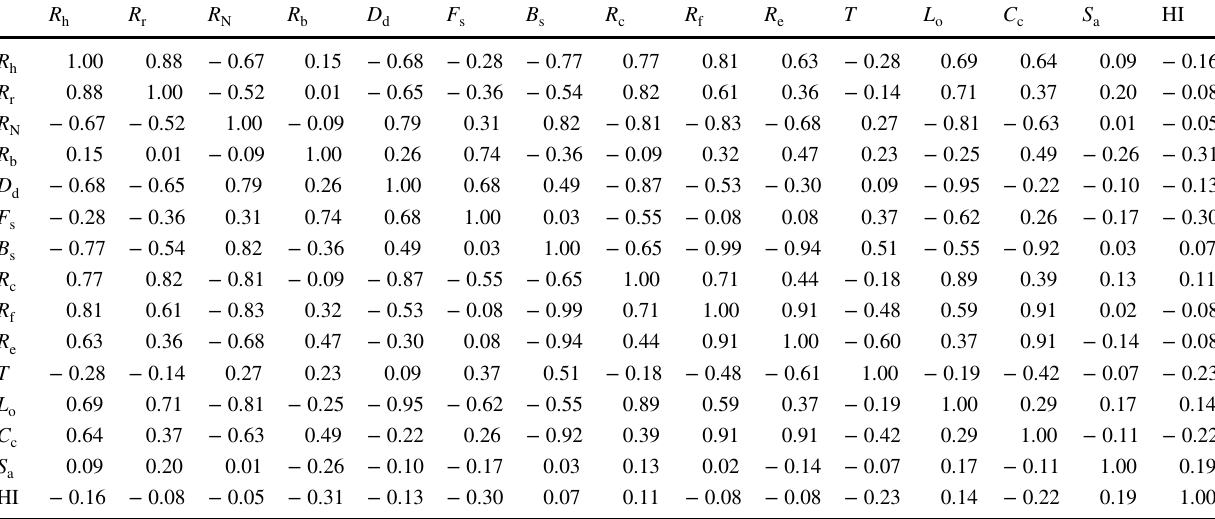
Table 7 Inter-correlation matrix among geomorphic parameters of the study area R